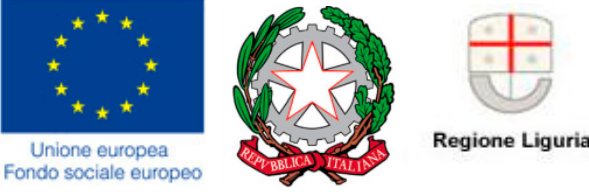
Table S1: Questionnaire for the biomass-to-energy plants; Table S2: District heating plants in north-west Italy; Table S3: Plants for electricity production from wood biomass in north-west